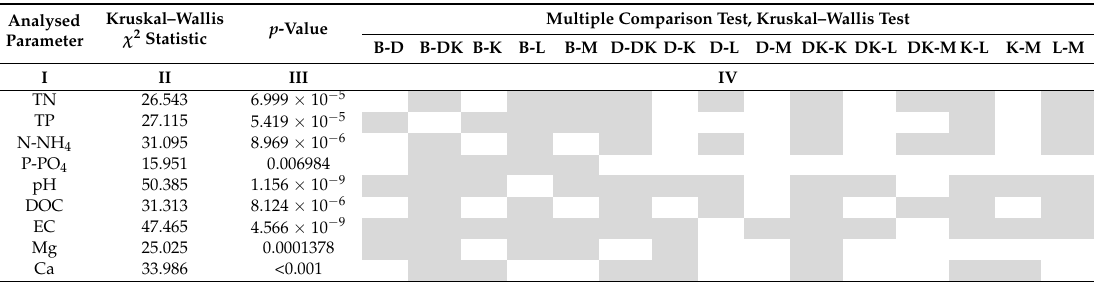
Table 1. Values of the Kruskal -Wallis test statistics, p -values and results of multiple comparisons for significantly variable parameters at particular study sites. Column I presents the type of the analysed parameter, column II of the table includes values of the obtained test statistics, column III includes the corresponding p -values. Results of multiple comparisons are presented in column IV, sites for which significant differences were obtained at a significance level of 0.05 are marked with a colour.